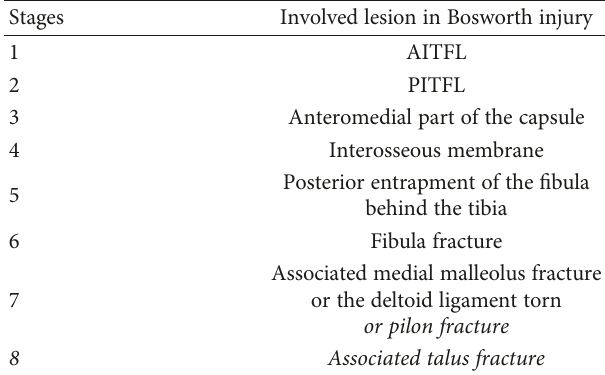
Figure 4: (a) AP and (b) lateral X-rays of the left ankle at 1 year, showing necrosis of the talus and pilon, with anteromedial articular con fl Table 1: Di ff erent stages involved in Bosworth injury. Seven stages are proposed by Perry et al. on a cadaveric study. In italic, complementary modi fi cations proposed by the authors.